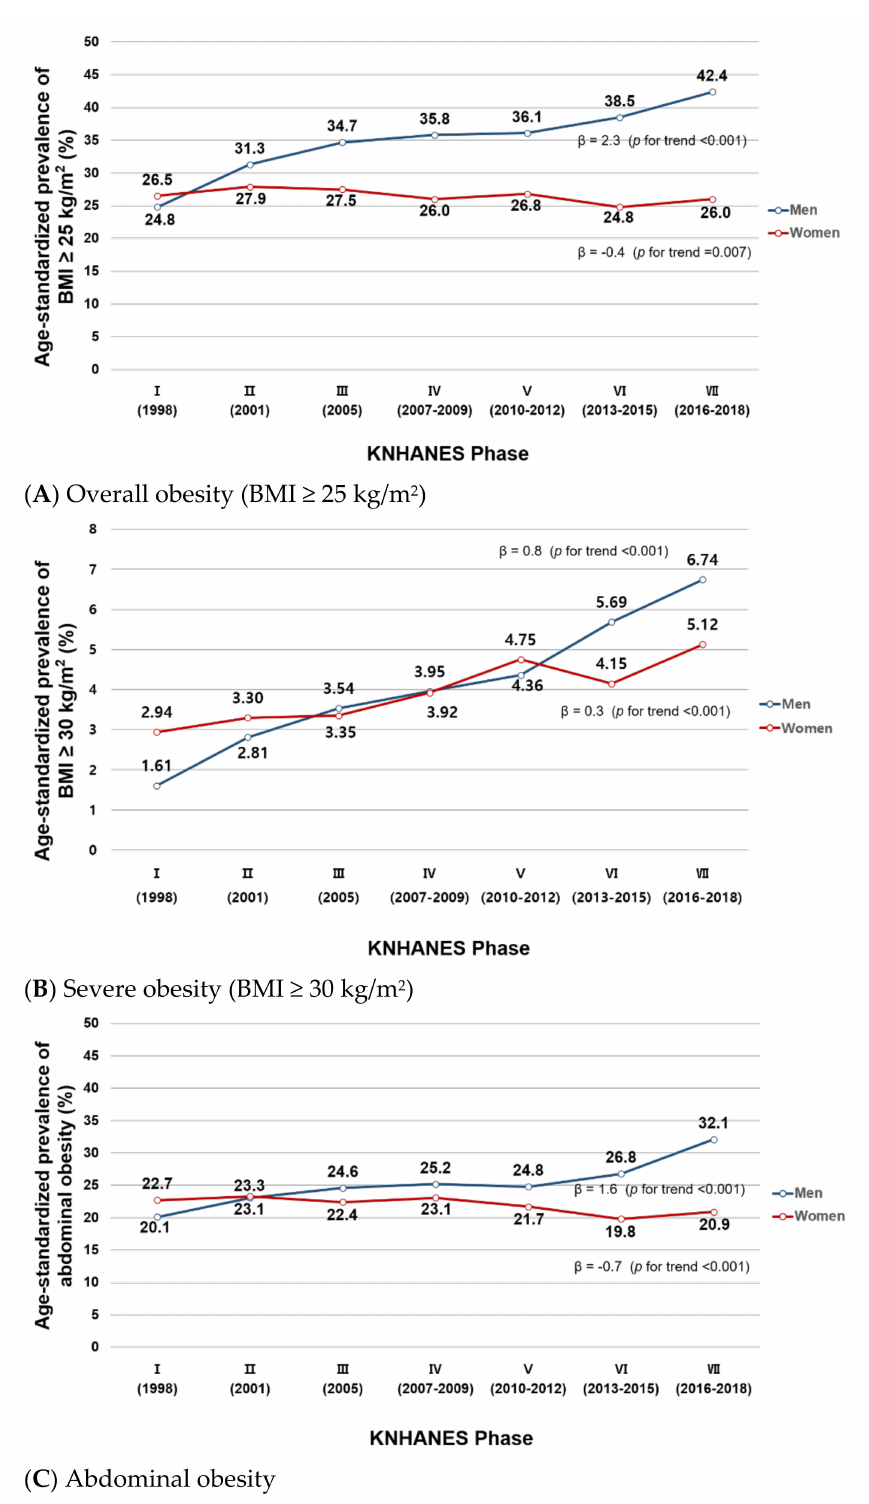
Figure 1. ( A – C ). Age-standardized prevalence of overall and abdominal obesity in Korean men and women from KNHANES I (1998) to VII (2016–2018). This figure shows the age-standardized prevalence of ( A ) overall obesity (BMI ≥ 25 kg/m 2 ), ( B ) severe obesity (BMI ≥ 30 kg/m 2 ), and ( C ) abdominal obesity in Korean men and women in the KNHANES I–VII. Age-standardization was performed using the 2005 Korean Census population as the reference